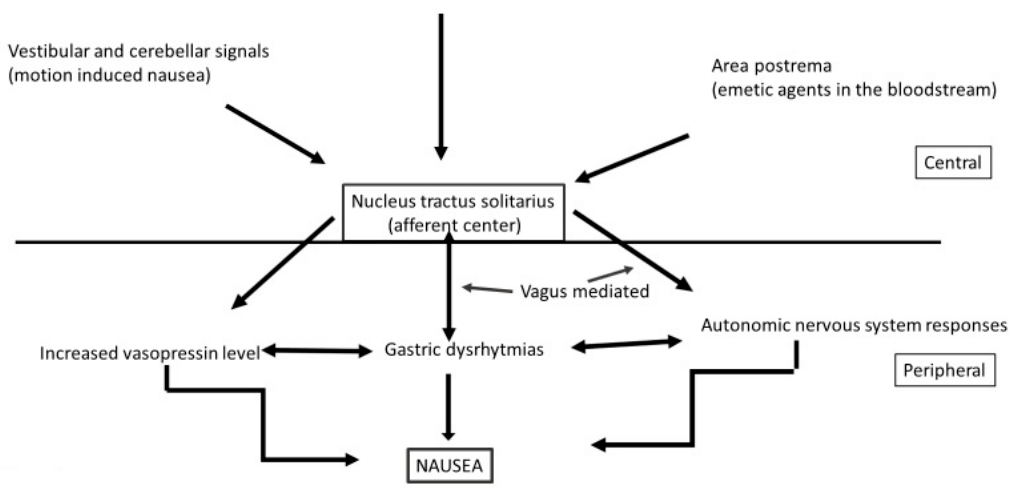
Figure 2. Pathophysiology of nausea.